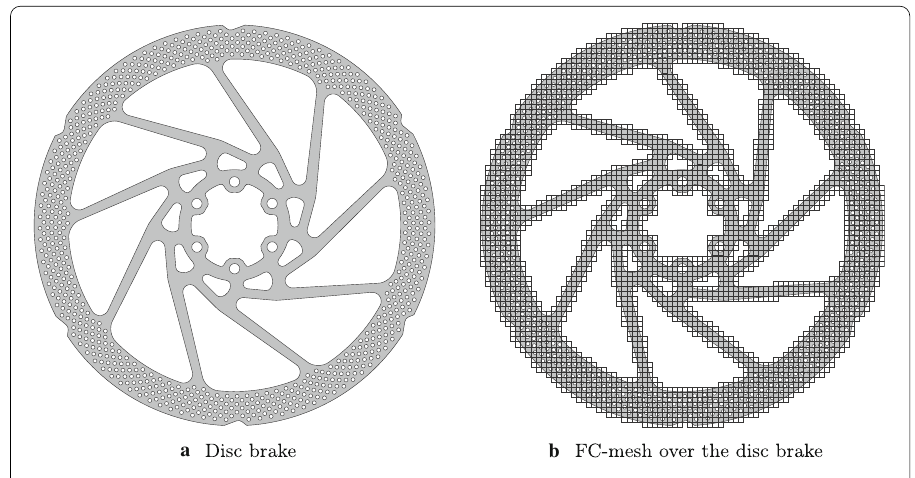
Fig. 30 Disc brake with a diameter of 200 mm and computational mesh used for the FC